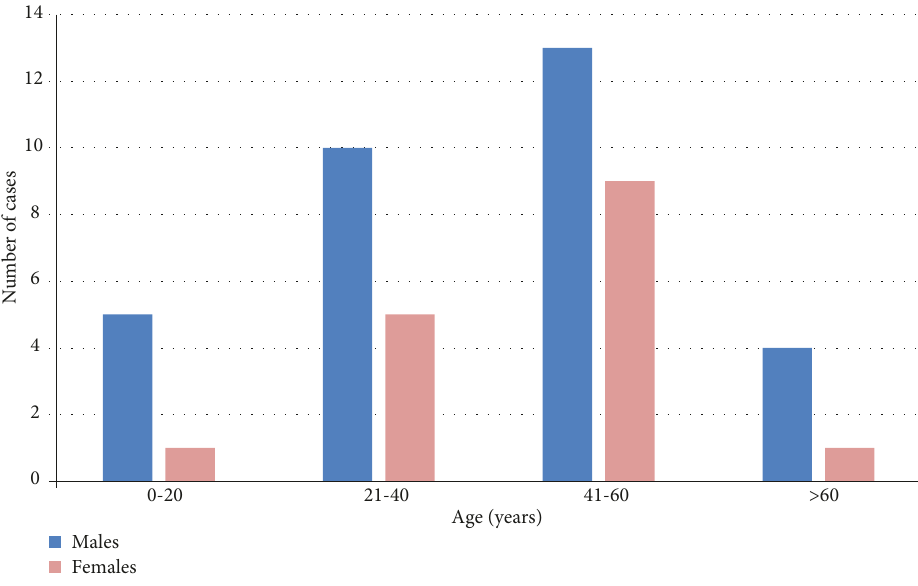
Figure 4: Distribution of age and sex in the 63 cases of angioleiomyoma of the oral cavity